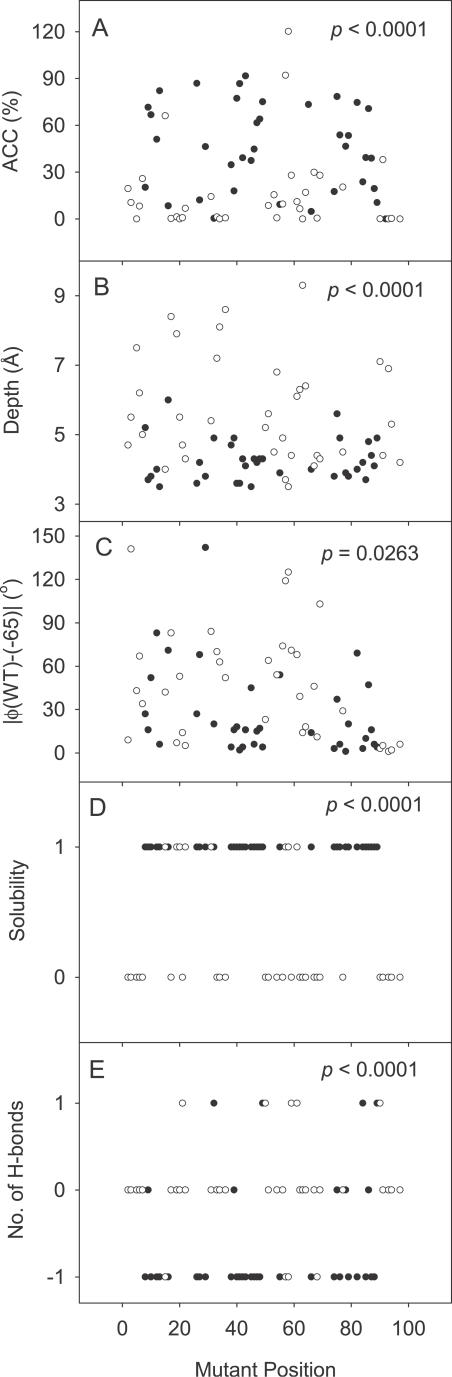
Correlation of Pro Mutant Activity with Various Structural Parameters of WT and Mutant Models of CcdBSolid circles represent active mutants and empty circles represent inactive mutants. (A) WT residue ACC, (B) WT residue depth, (C) |φ(WT) − (−65)| (D) solubility of mutant (0 denotes insoluble and 1 denotes soluble), (E) number of H-bonds formed by WT residue in native structure and acceptor in mutant models (−1 denotes WT amide not involved in H-bond, 0 denotes WT amide involved in H-bond but acceptor of this amide group not satisfied in any of the mutant models and 1 denotes acceptor forms new H-bond in at least one mutant model). Correlations with p-values less than 0.05 are considered statistically significant.